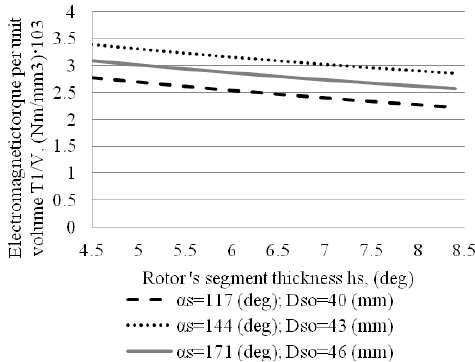
Fig. 6. Maximum value of electromagnetic torque per unit volume according to thickness of rotor’s segment.